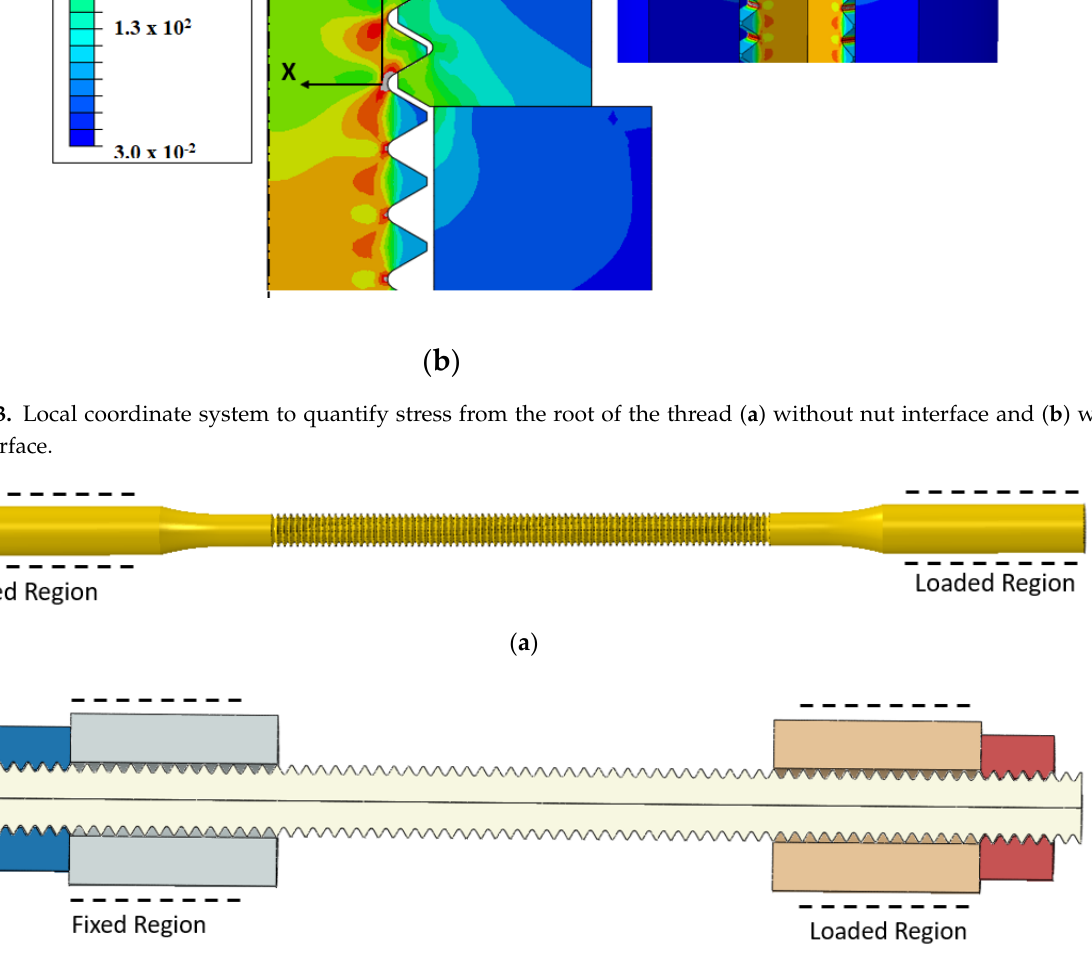
Figure 4. Regions attached to the wedge grip system ( a ) threaded specimen ( b ) stud specimen.